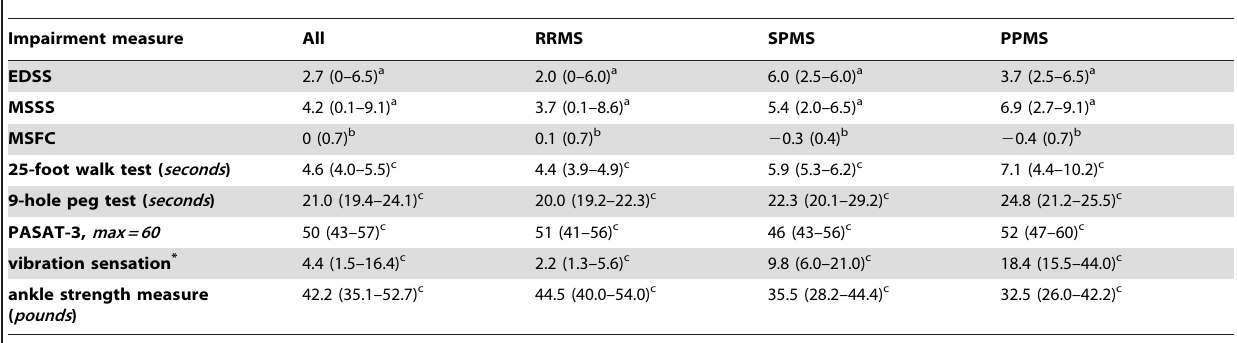
Table 1. Cohort demographic data.